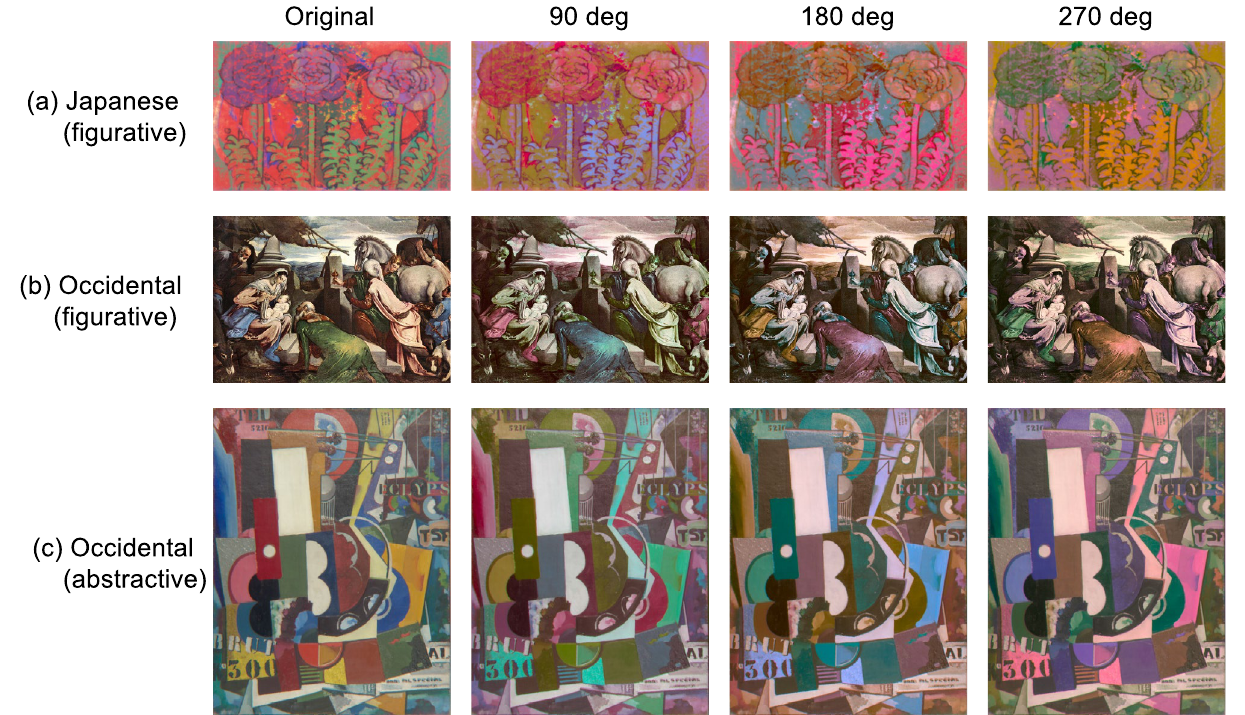
Figure 2. Typical examples of original and hue‑rotated images used in the experiments. ( a ) Japanese painting on Japanese paper ( washi ) by Masayoshi Nakamura (1924–1977), late twentieth century; ( b ) oil painting on canvas by Jacopo Bassano (ca. 1510–1592) in 1569. ( c ) oil painting on canvas by Amadeo de Souza-Cardoso (1887–1918) in b*, respectively. The hue‑rotated images were obtained by rotating the color gamut of the originals, a set of points for each pixel coordinate in the CIELAB color space, around an axis parallel to the L* axis passing through the mean chromaticity point on the a*–b* plane. The original corresponded to 0 degrees and the other three hue‑ rotated images were obtained by rotating the color gamut by 90, 180, and 270 degrees counterclockwise on the a*–b* plane. Figure 2 presents typical examples of the hue‑rotation effect on color appearance in both Occidental and Japanese paintings. When the hue of the original images displayed on the monitor screen were rotated, some pixel colors were outside the gamut of the monitor. Colors out of the gamut were projected onto the closest dis‑ playable colors in the CIELAB color space and chromatic errors occurred for these pixels. The largest chromatic error among the hue‑rotated images used in the experiments was (cid:31) E ab = 3.8 , which is near the threshold for complex images 45,53 ; thus, the effect of the gamut compression caused by the hue rotation was fairly negligible. Experimental conditions. Some paintings used in the experiment contained familiar objects associated with specific memory colors, such as a blueish sky 54 . To demonstrate whether hue‑angle preference depended on the overall color composition of the paintings or specific objects’ colors in the paintings, the spatial scramble was introduced to manipulate the spatial composition and visibility of the figurative elements of the paintings, as shown in Fig. 3. In C0 (Original condition), originals (selected from Set 1 in the main experiment and from Set 2 in the replication experiment) and hue‑rotated images were preserved in their original spatial form. In C1 (Scrambled condition), each original image was divided into a set of small square pieces with a side length of 73 pixels (10% of the height of the image), and the position was randomized. The generated images were the same size as the originals and were used to create the hue‑rotated images. In C2 (Patchwork condition), each image was divided into a set of small pieces in the same manner as for C1, and each stimulus was generated by composing 100 randomly selected pieces (10 × 10 pieces) from the groups of 20 different paintings measured at museums or of 20 different paintings from the galleries on the Internet, in a mixture of all three sets (Sets 1, 2, and 3). In C3 (Randomized condition), each stimulus was generated from pieces of different images similar to that in C2; however, each piece was selected from the hue‑rotated images with a random degree from the original. In each condition, ten sets of four types of images, including original or generated images, were used as stimuli. In C2, five images each were generated from images measured at museums and from art painting galleries on the Internet. In C1, C2, and C3, the original paintings were divided into small pieces (73 × 73 pixels) to make it difficult to identify any specific objects from one piece. In C1, the generated images had color compositions identical to the originals. In C2, the population of the generated images had the same color statistics as the population of the 20 original paintings. In C3, the generated images were randomized spatially and chromatically from the originals. Therefore, by comparing the results of C0 with C1, C2, and C3, it was possible to determine whether